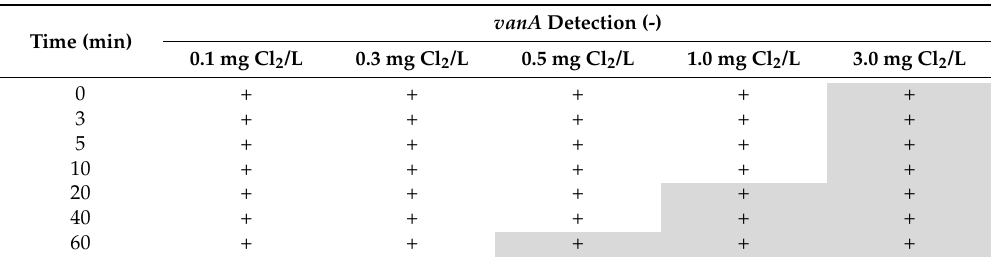
Table 2. vanA detection for each initial chlorine concentration and treatment time (suspensions of VRE in PBS solution).